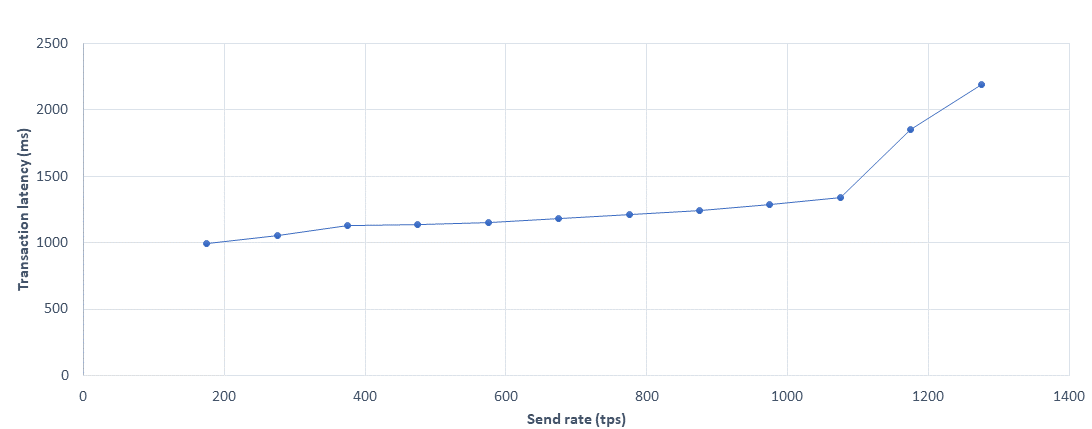
Figure 13. Average transaction latency evaluation.